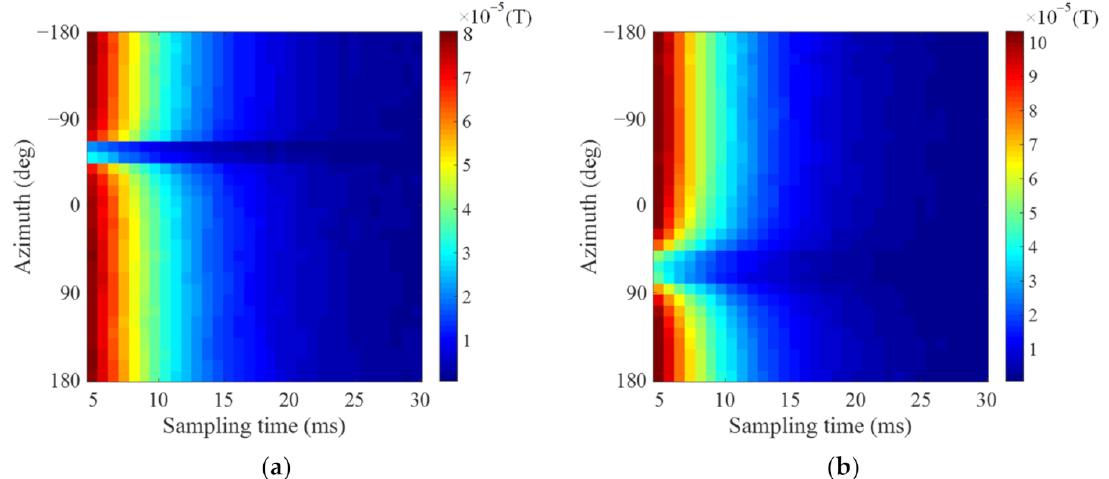
Figure 13. Azimuth-time images of two asymmetry defects at different depths: ( a ) 66.5 m; ( b ) 88.7